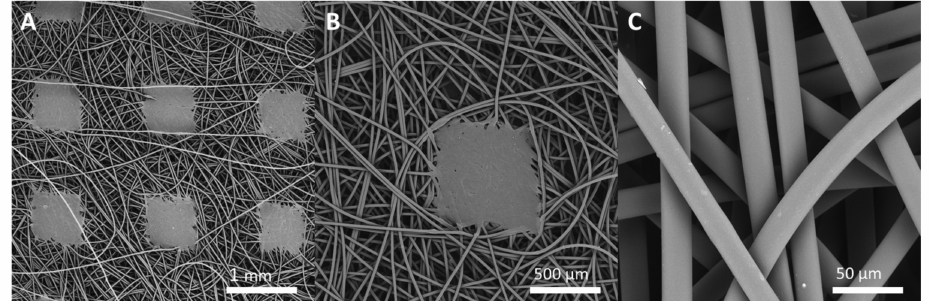
Figure 3. SEM images of: ( A – C ) non-woven polypropylene mat. All images were collected at accelerating voltage 20 kV using BSE detector. Magnification: ( A ) 10 × , ( B ) 50 × , ( C ) 1000 ×